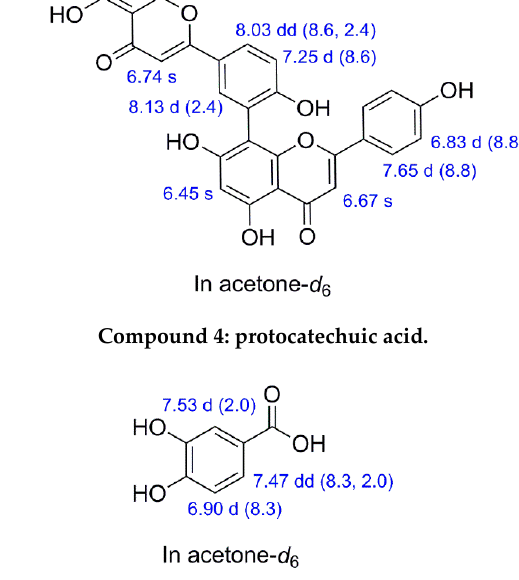
Figure 6. H 1 -NMR (nuclear magnetic resonance) data of sitoindoside I, tetrahydroamentoflavone, amentoflavone, and protocatechuic acid (500 MHz, acetone-d 6 ).